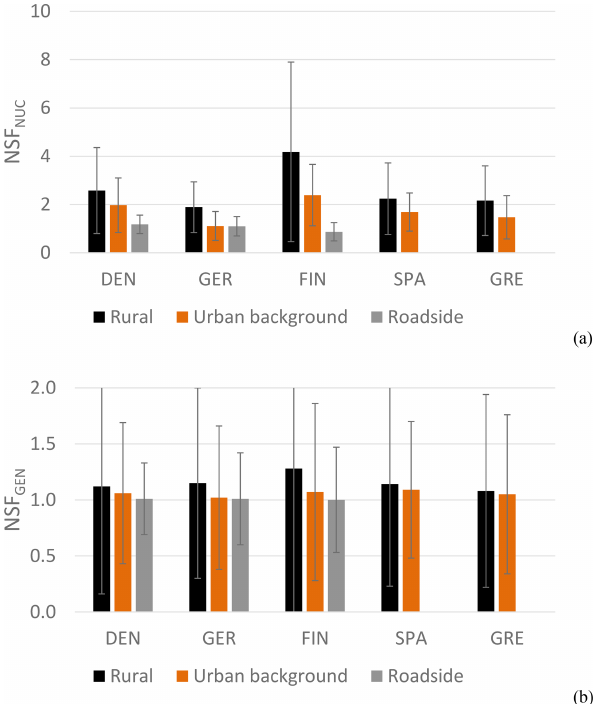
Figure 9. (a) NSF NUC (average relative increase of ultrafine parti- cles – particles of diameter up to 100nm) due to new particle forma- tion events on event days) and (b) NSF GEN (average annual relative increase of ultrafine particles due to new particle formation events) at all